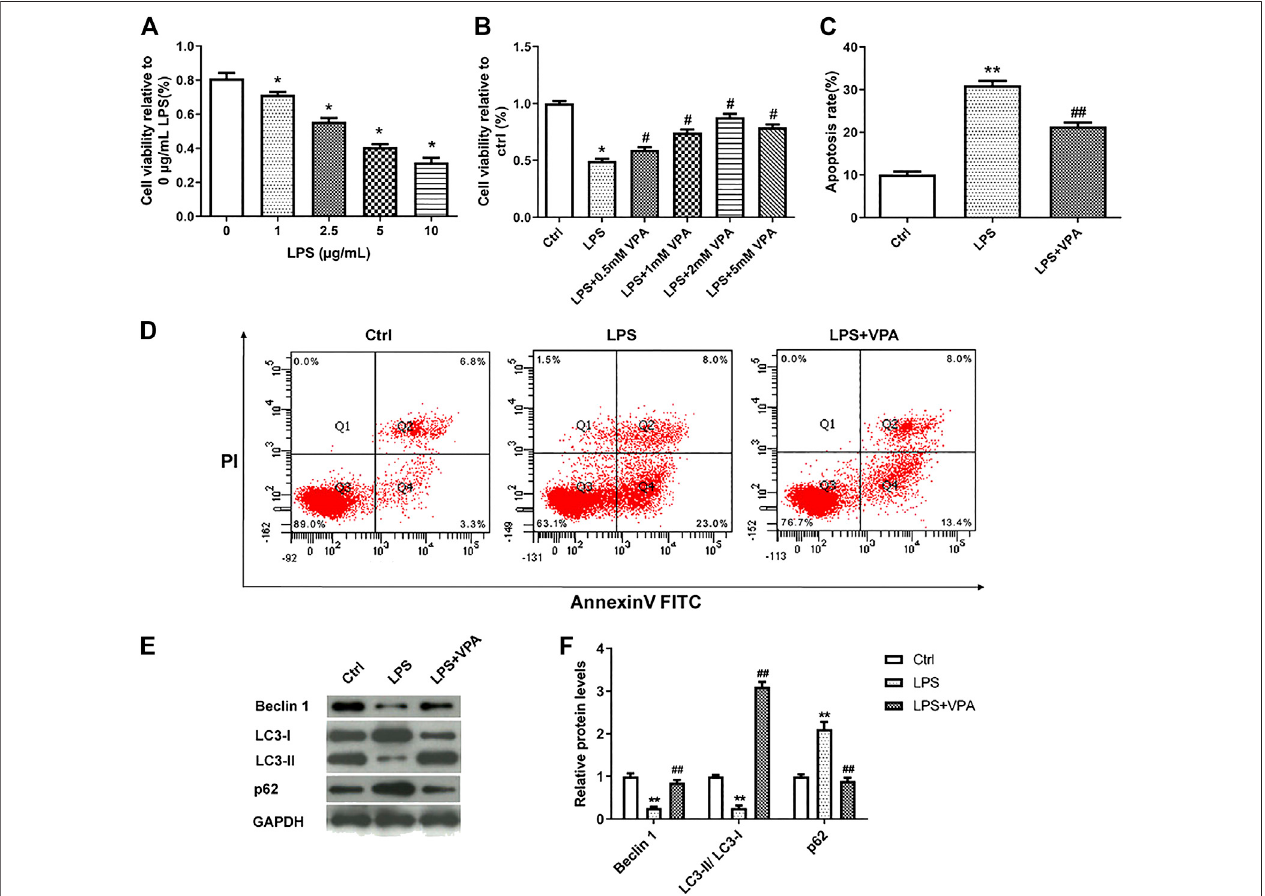
FIGURE 2 | VPA ameliorates LPS-induced injury in CHON-001 cells. (A) The effect of LPS on the cell viability in chondrocytes using CCK-8 kit. * p < 0.05. (B) VPA treatment reversed thecell viability ofLPS-induced CHON-001 cells, based on the CCK-8 assayresults. * p < 0.05, # p < 0.05. (C,D) The apoptosis rate ofchondrocytes wasdetected with Annexin V-FITC/PI double stainingassay. ** p < 0.01, ## p < 0.01. (E,F) Protein levels ofBeclin 1,LC3-I,LC3-II, and p62 wereassessed usingwestern blotting and quanti fi ed. ** p < 0.01, ## p < 0.01. The average of three independent experiments in triplicate is shown with error bars indicating mean ± SD (ANOVA followed by Tukey ’ s post hoc